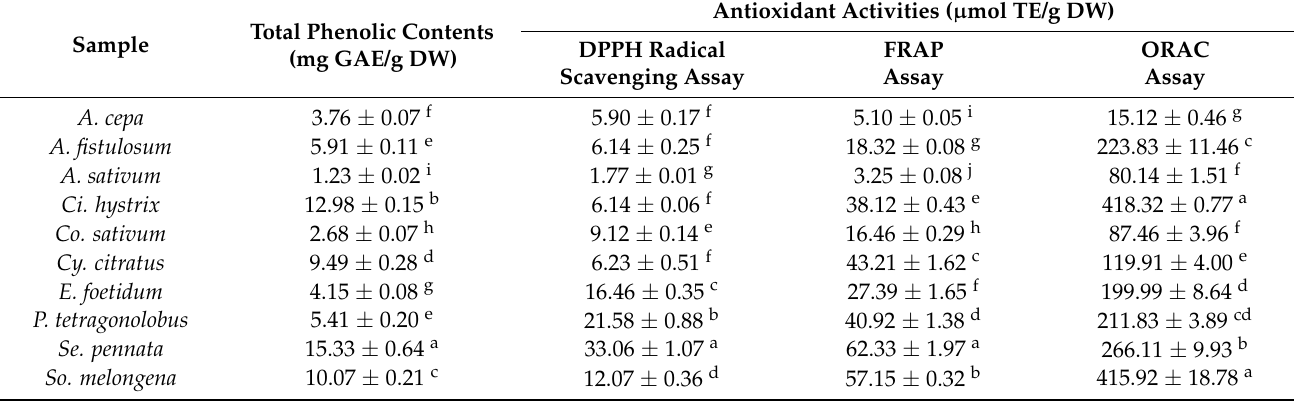
Table 3. Total phenolic contents and antioxidant activities of the ten vegetable